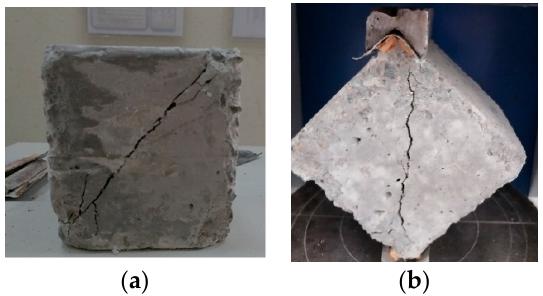
Figure 11. Tensile diagonal failure for certain cubes at 28 and 56 days: ( a ) M1 at 56 days; ( b ) M2 at 28 days.